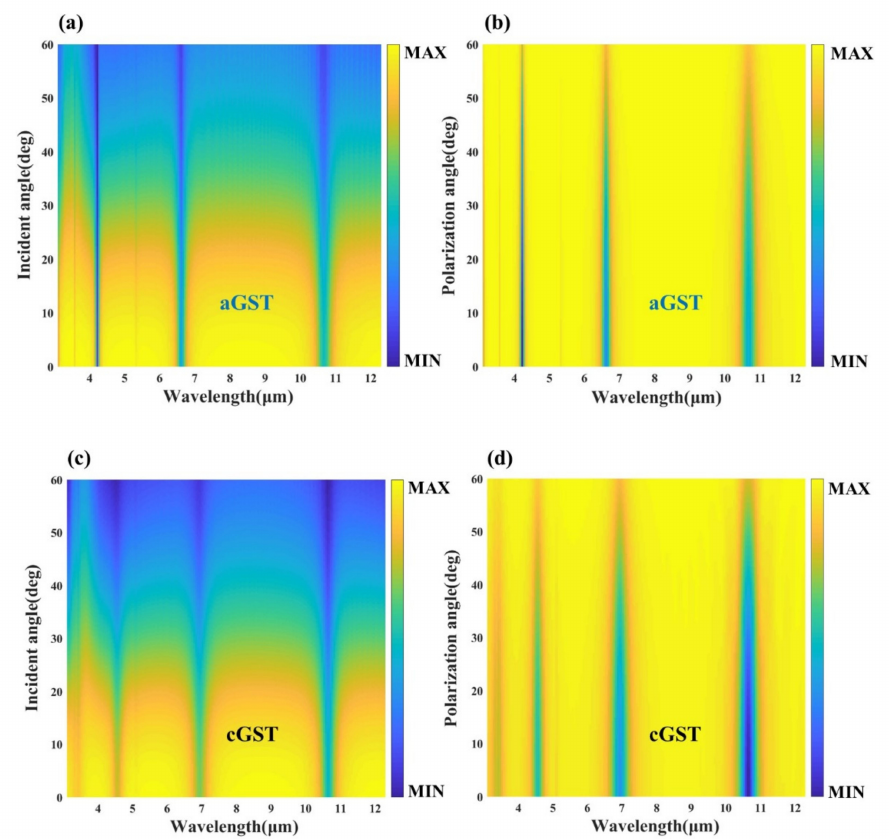
Figure 8. Reflectance spectra of the proposed five-layer structure in the infrared band: ( a ) aGST at different incident angles, ( b ) aGST at different polarization angles, ( c ) cGST at different incident angles and ( d ) cGST at different polarization angles.